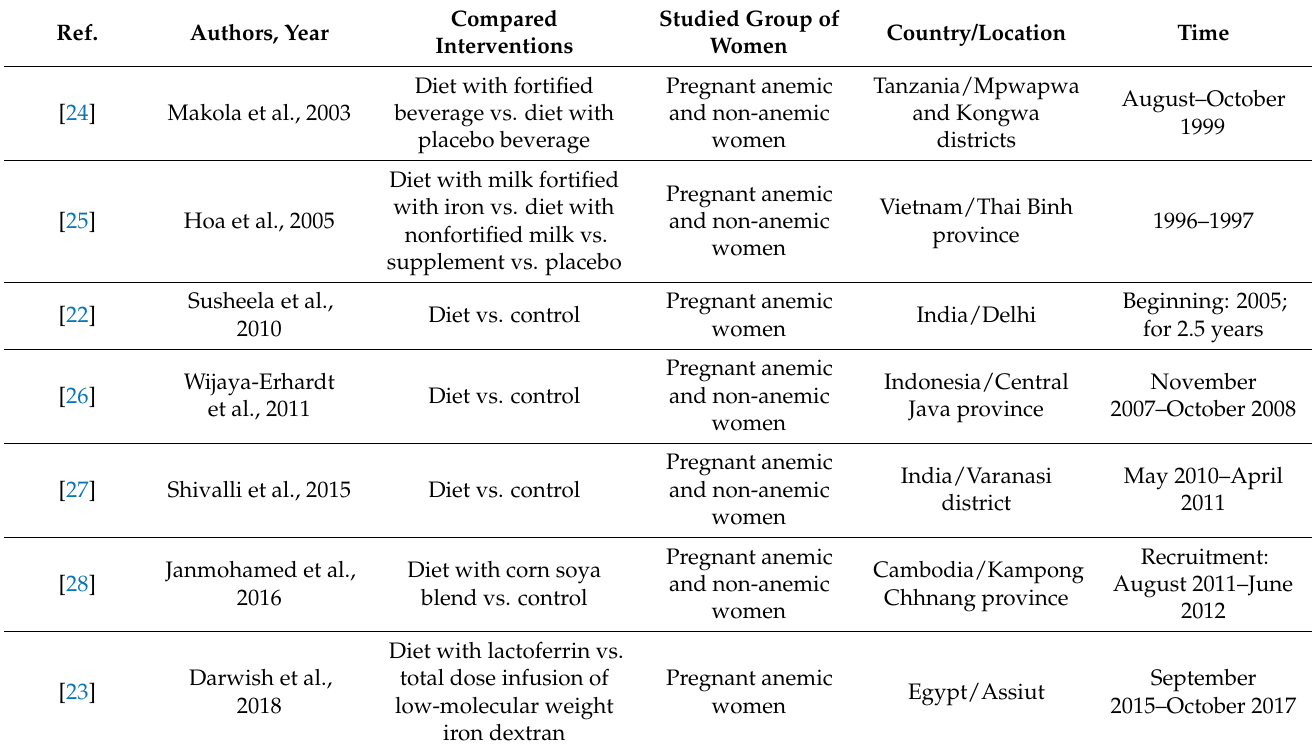
Table 3. The basic characteristics of the randomized controlled trials included in the systematic review [22–28].